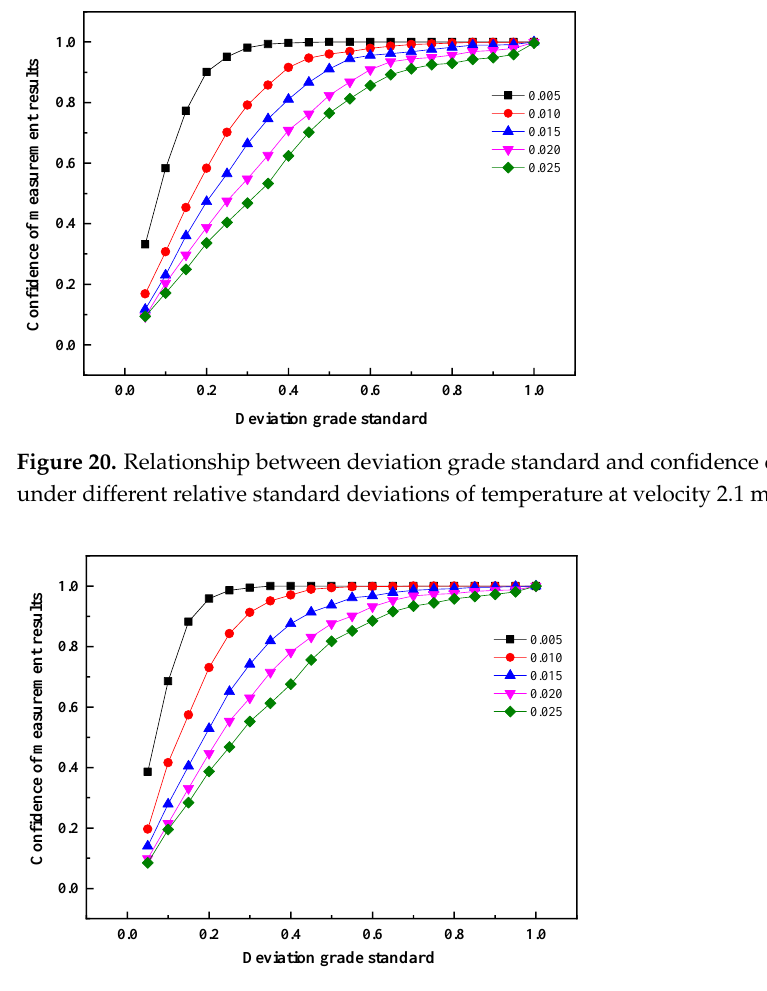
Figure 21. Relationship between deviation grade standard and confidence of measurement results under different relative standard deviations of temperature at velocity 3.2 m/s.